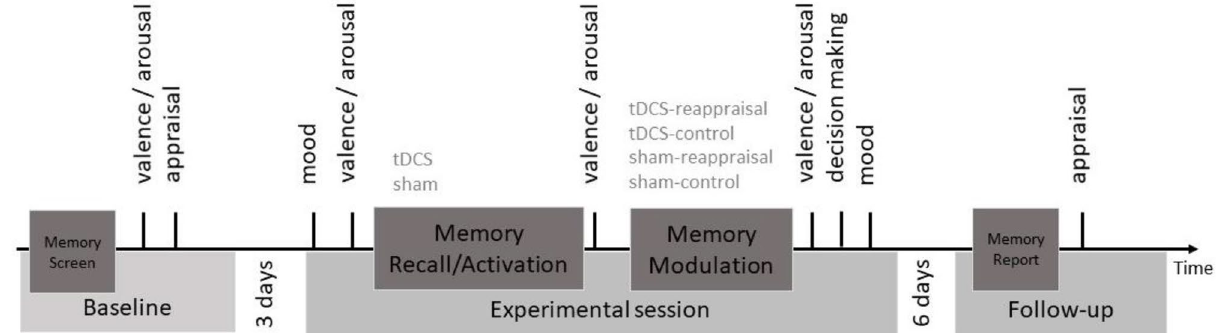
Figure 1. Timeline of the experiment. At baseline, participants’ negative emotional memory was screened, and participants rated valence, arousal of the memory and evaluations (memory screen). During the experimental session, participants completed a mood state questionnaire and again rated valence and arousal (memory recall/activation). Anodal or sham tDCS was applied over the participants’ right dorsolateral prefrontal cortex (dlPFC). Stimulation began 3 min before the beginning of the testing to allow neuroplastic effects to stabilise. In these three minutes, participants engaged in a standardised breathing protocol (see above). To minimise the cutaneous sensation of current onset and offset, tDCS was ramped up in the beginning to maximum intensity for 5 s and ramped down over 5 s in the end. Stimulation was applied for 20 consecutive minutes throughout the experiment, starting from the beginning of the experimental session and continued throughout the experiment. Participants then rated valence and arousal of the memory. They then listened to the reappraisal or the control audiotape for memory modulation and completed valence and arousal ratings (memory modulation). Decision making and mood were assessed. During follow-up, positive and negative evaluations were